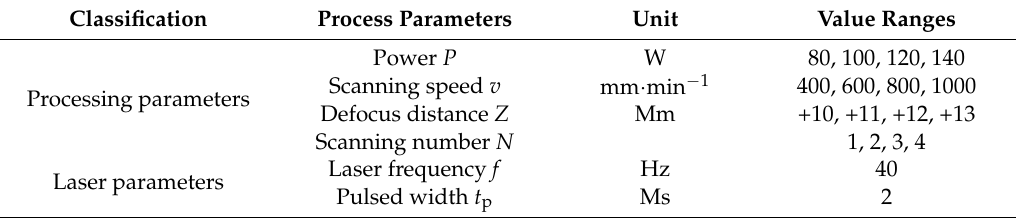
Figure 4. Experimental devices of laser bending: ( a ) Laser bending system; ( b ) Schematic diagram of laser bending. Table 1. Experiment conditions with different laser